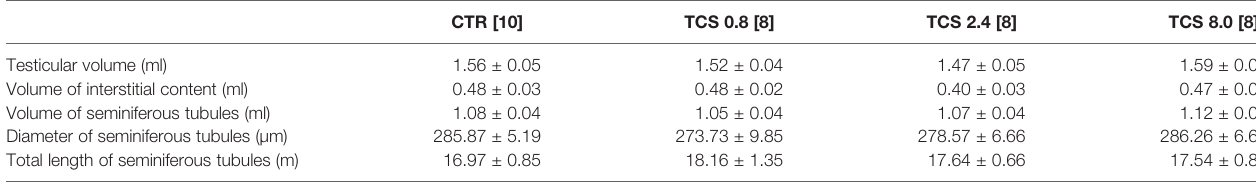
TABLE 5 | Volumetric composition (ml) and biometric evaluation of testicular parenchyma of male rats of F1 generation at PND 140.